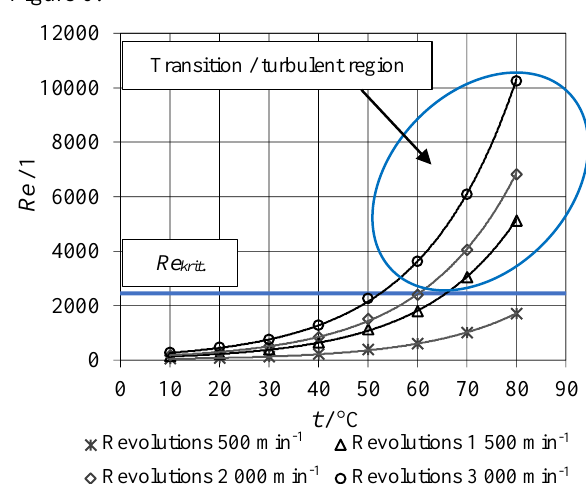
Fig. 6. Dependence of the Reynolds number Re on the oil temperature t